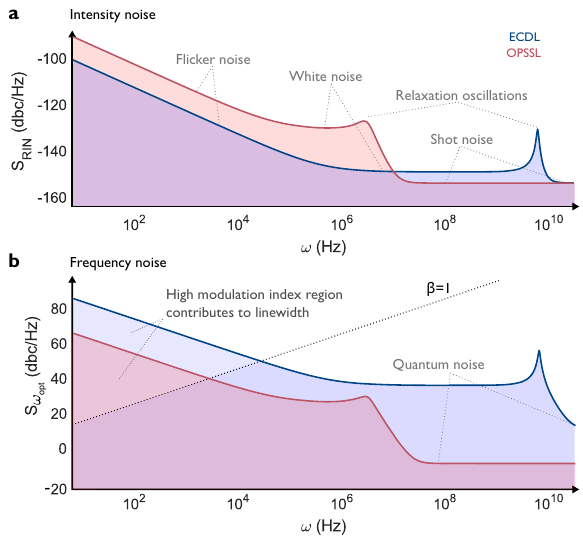
Fig. 2 Idealised free-running laser noise PSDs for external cavity diode lasers (ECDL) and optically-pumped solid-state lasers (OPSSL). a The RIN PSD, demonstrating the low frequency 1/ ω ( fl icker) noise, mid-frequency white noise, the relaxation oscillation peak, and shot noise. b The frequency noise PSD with the same general features as RIN with a fundamental limit of quantum noise. The noise above the β -separation line contributes to the linewidth of the laser, while the noise below the β -separation line contributes to the wings of the laser